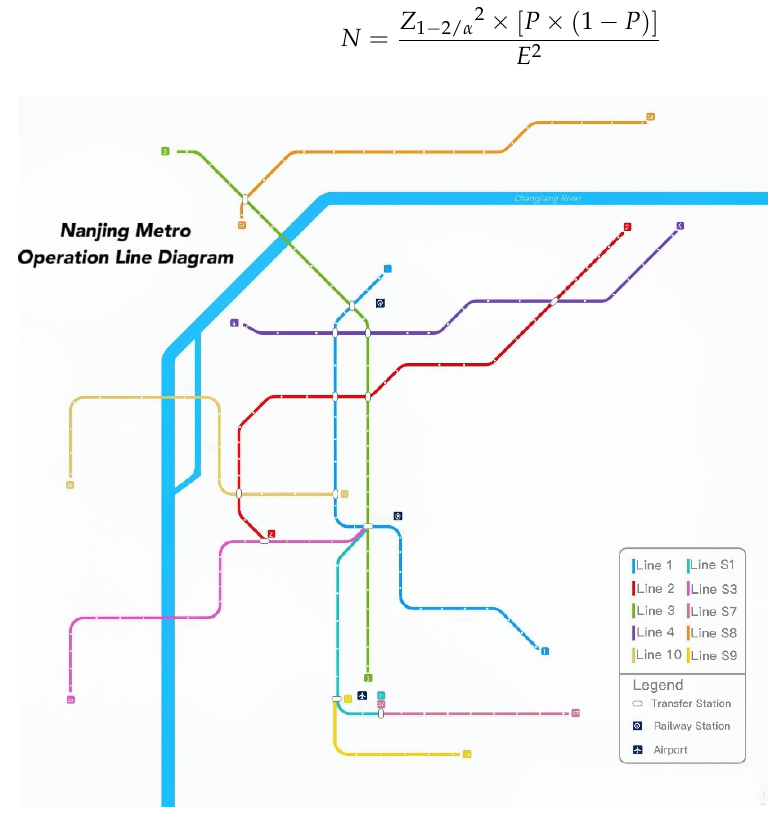
Buildings 2022 , 12 , x FOR PEER REVIEW Figure 2. Nanjing Metro operation line diagram. Figure 2. Nanjing Metro operation line diagram.